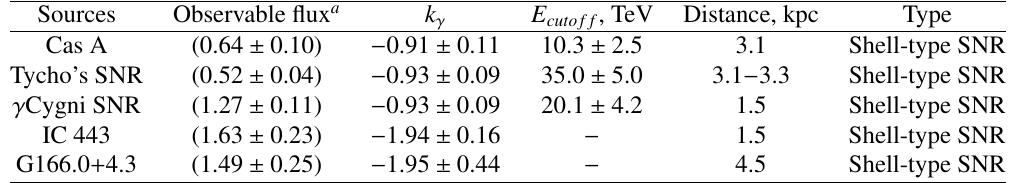
Table 1. The catalogue of galactic γ -ray sources by SHALON with parameters for spectrum fitting in the form of a power law